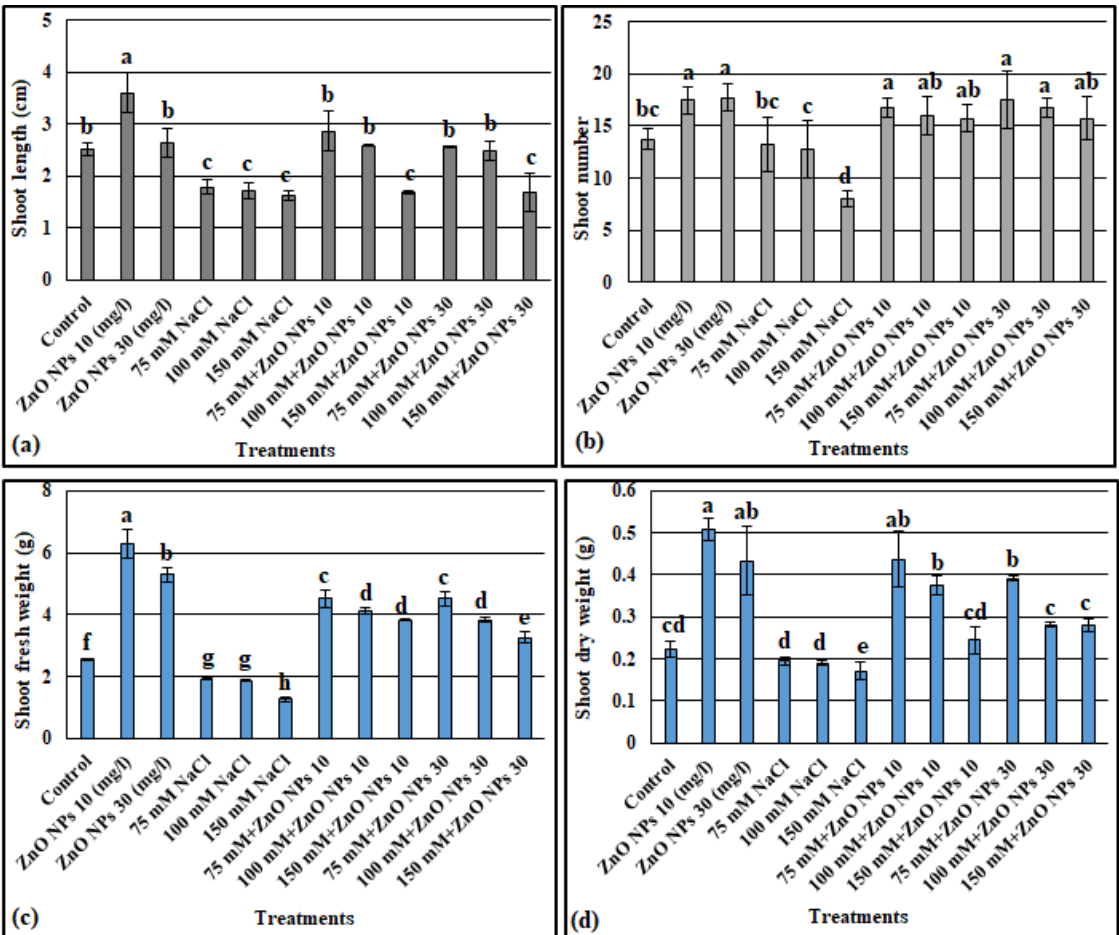
Figure 5. ZnO NPs (10 mg/L and 30 mg/L) effects on shoot length ( a ), shoot number ( b ), shoot fresh weight ( c ), and shoot dry weight ( d ) of Salvia officinalis subjected to 0, 75, 100, and 150 mM NaCl. Each value is the mean of three replicates ± SD. The significant differences between the treatments are indicated by different letters on bars. The Duncan’s test at p < 0.05 was used for this analysis.